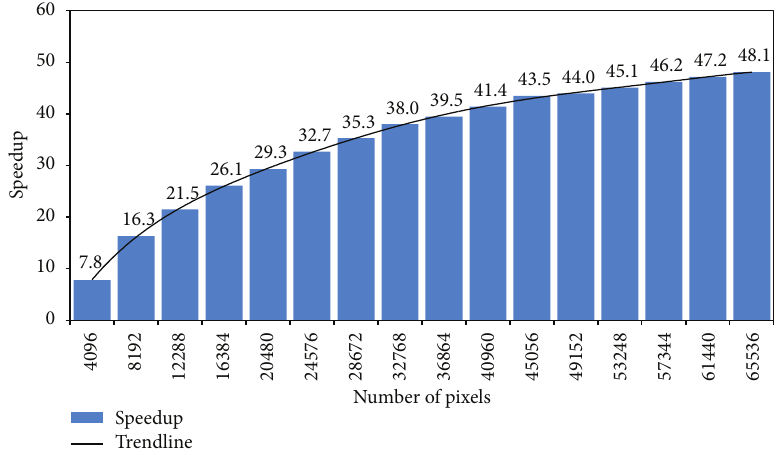
Figure 8: The speedup of the GPU parallel algorithm to the CPU serial algorithm for the 16 data